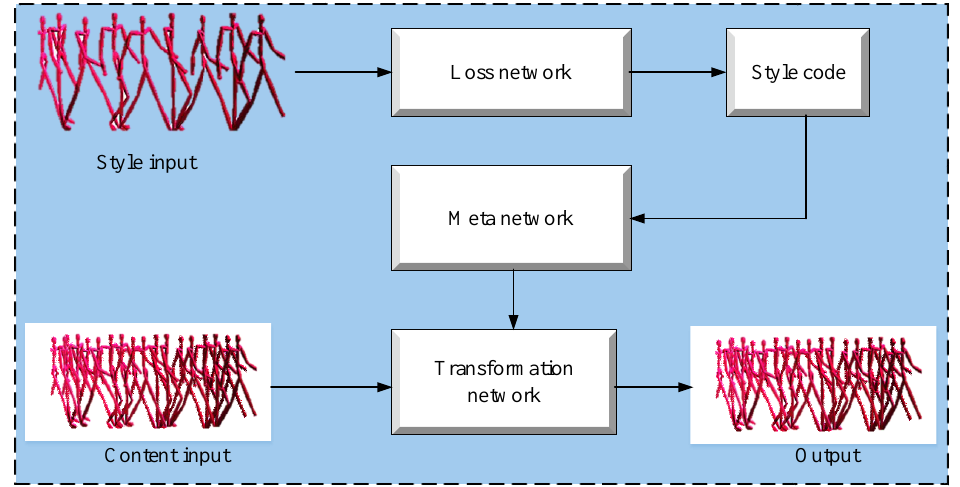
Figure 1. Meta network-based motion style transfer from motion-captured